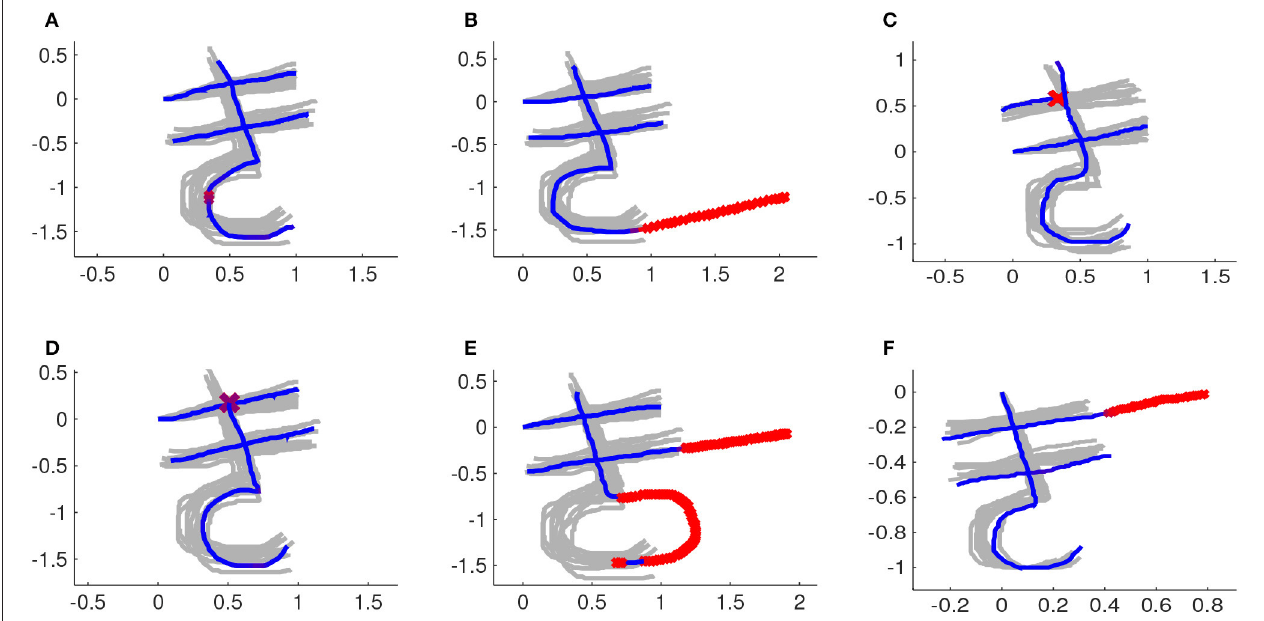
FIGURE 12 | The demonstrations after rescaling, repositioning and time-alignment are depicted in light gray. Parts of a new trajectory that are considered correct are depicted in blue. Parts of a new trajectory that are considered wrong are marked with red x’s . (A) Instance with a small mistake in the third stroke. (B) Third stroke goes further than it should. (C) First stroke is too short. (D) Third stroke starts too low. (E) Second stroke is too long and third stroke has its arch in the wrong direction. (F) First stroke is too long.